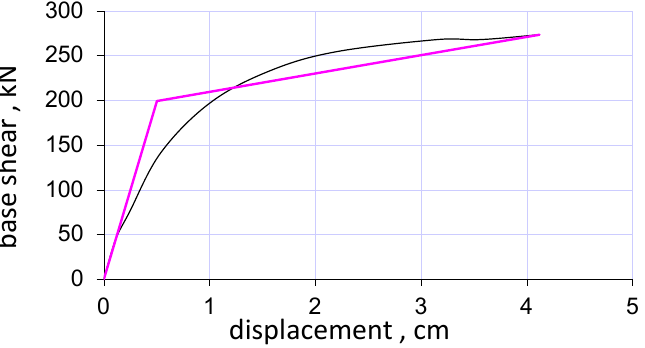
Figure 12. The two-line graph resulting from the cyclic loading curve.